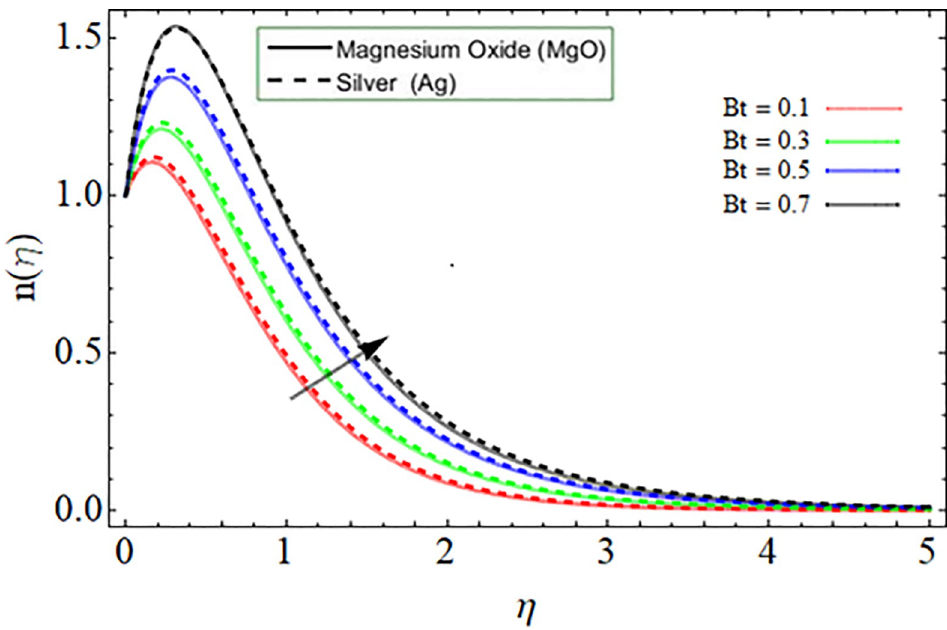
fluctuation of a wavy gyrating disc. Magnesium oxide and silver nanoparticles have been heavily reported to have broad-spectrum antibacterial operations among metal oxides and metals. However, in current paper, the study’s goal is to increase the rate of thermal energy propagation for a variety of industrial applications. For the purpose, the problem has been